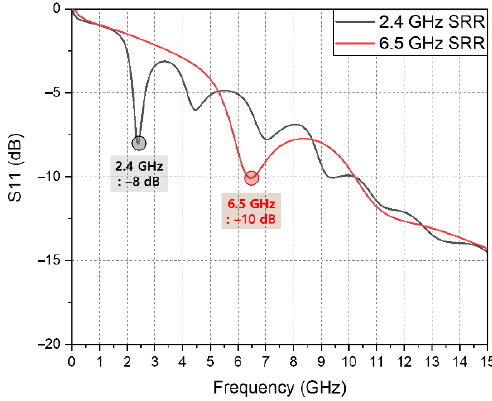
Figure 4. Simulated S-parameter of SRR with a brain model.